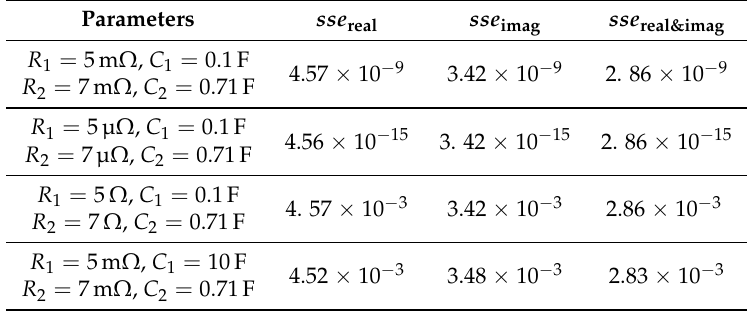
Table 2. The sum of squared errors ( sse ) of the reconstructed impedance spectrum using DRT varying A and b . RC-ZARC elements. For the ZARC, ϕ = 0.8 is kept constant. Also, λ = 0.1, n = 3